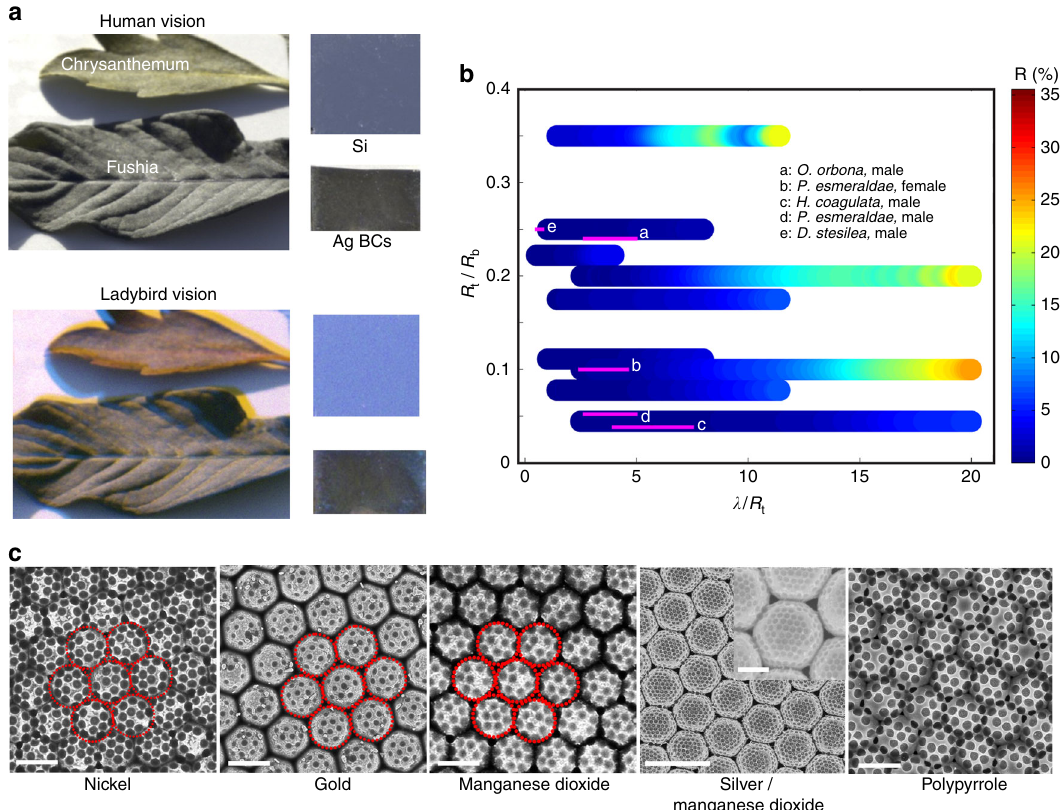
Fig. 5 Possible camou fl age function of BCs and their fabrication in different materials compositions. a Simulated human and ladybird beetle visions of BCs and two different leaf species. b Comparison of the structural parameters of natural and synthetic brochosomes for their optical re fl ectance; here, the color bar represents the experimental re fl ectance measurements of various synthetic BC structures and the magenta lines represent the natural brochosomes (i.e., the visible spectrum of the ladybird over R t determines the line length and position along the x -axis). These natural brochosomes include a Oncometopic orbona , male. b Proconia esmeraldae , female. c Homalodisca coagulata , male. d Proconia esmeraldae , male. e Diestostemma stesilea , male (Supplementary Fig. 24). The observing (incident) angle is 45°. Note that the geometrical parameters of the aforementioned natural brochosomes are located at the low re fl ection region in the optical re fl ectance map obtained from the re fl ectance measurements of the synthetic brochosomes. The normalized plot allows one to identify the corresponding antire fl ection design parameters of the synthetic brochosome given a speci fi c wavelength of light. c Scanning electron micrographs showing various BCs fabricated from nickel (Ni), gold (Au), manganese oxide (MnO 2 ), silver/manganese oxide (Ag/MnO 2 ), and polypyrrole (PPy). Scale bars: 2 µ m (Ni, Au, MnO 2 , PPy) and 5 µ m (Ag/MnO 2 , inset, 2 µ